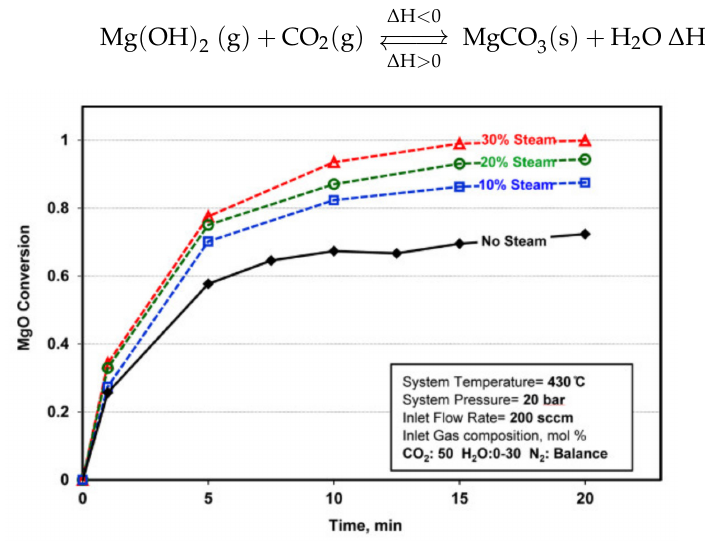
Figure 19. Effect of steam on Mg-based sorbent reactivity and capacity. (Reprinted with permission from [186]. 2015, Zarghami et